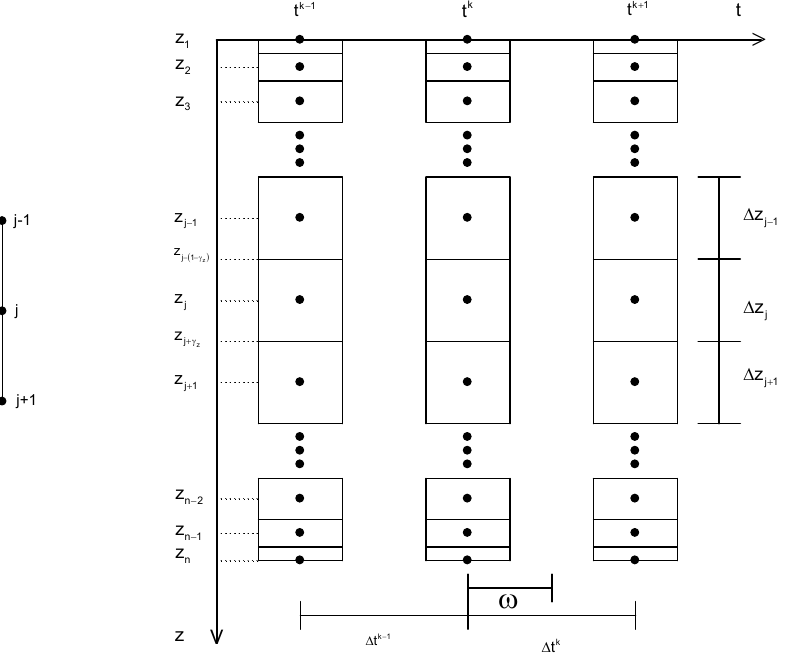
Figure 1. The domain resolution of the Richards equation; ω is the is the interpolation factor in time and γ is the interpolation factor in space.